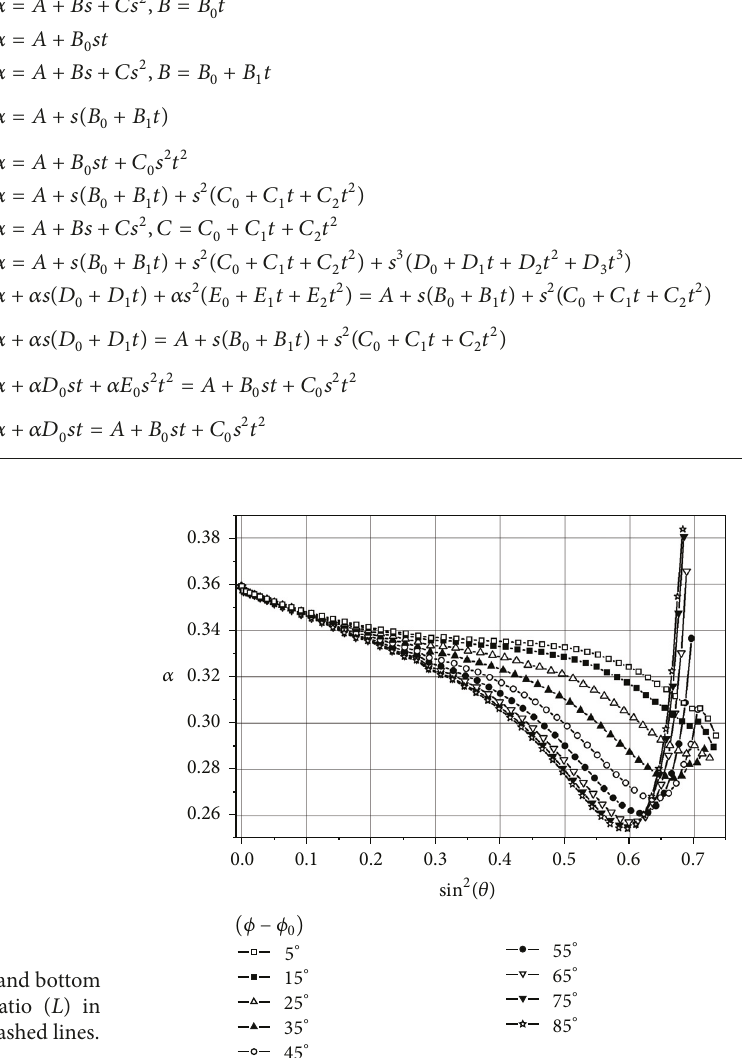
Figure 2: The attenuation factor for variant 𝑉 𝑃3 = 4800